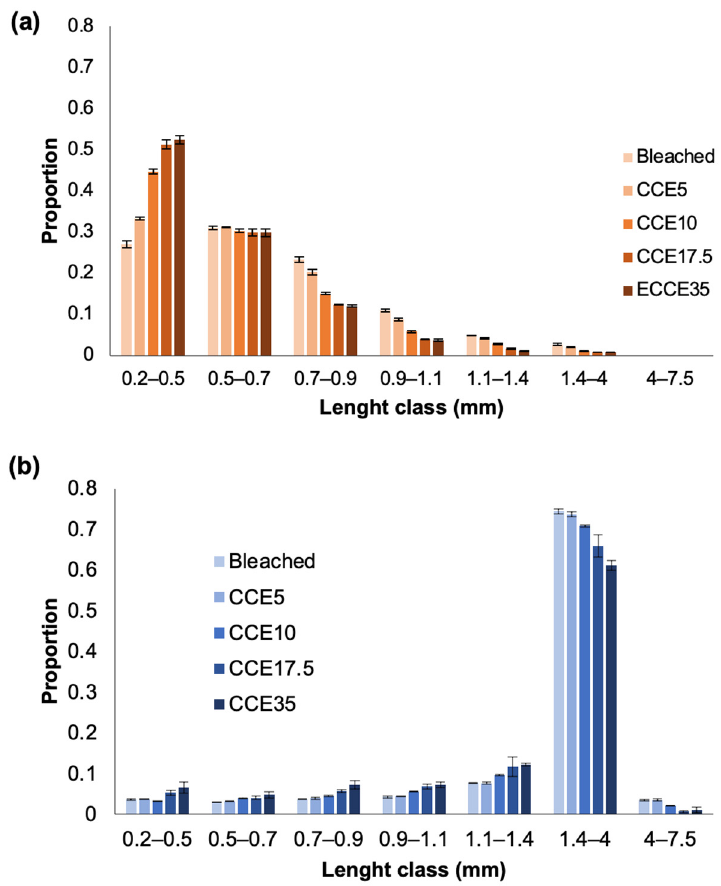
Figure 1. Fiber length classes distribution in ( a ) eucalyptus and ( b ) pine pulps after alkalization with different NaOH concentrations.